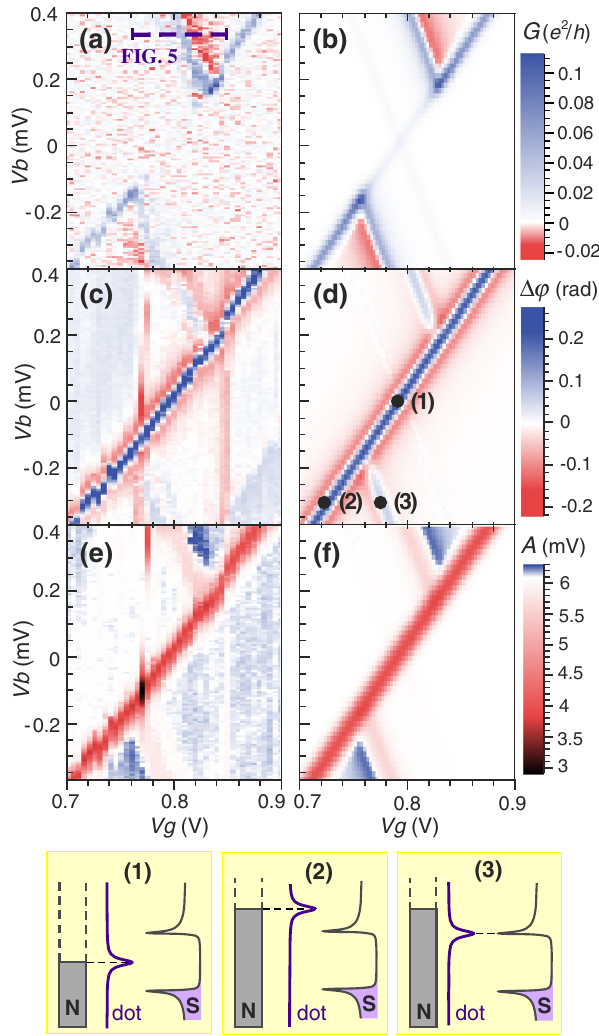
FIG. 4. Panels (a), (c), and (e): Measured linear conductance G , phase shift Δ φ , and total amplitude A of the transmitted micro- wave signal versus the dot gate voltage V and the bias voltage g V . Panels (b), (d), and (d): Predictions from Eqs. (3), (6), and b = 2 π ¼ 0 . 6 GHz, Γ = 2 π ¼ 65 MHz, Γ = 2 π ¼ (B17), for Γ N S n 8 GHz, g= 2 π ¼ 99 MHz, Δ ¼ 0 . 17 meV, T ¼ 90 mK, ω 2 π ¼ 0 = 6 . 65 GHz, A 6 . 1 mV, and Λ 2 π ¼ 0 . 259 MHz. The white 0 ¼ 0 = color corresponds to A ¼ A 0 in panels (e) and (f). Panels (1), (2), and (3): Electric potential configuration corresponding to the black points in panel